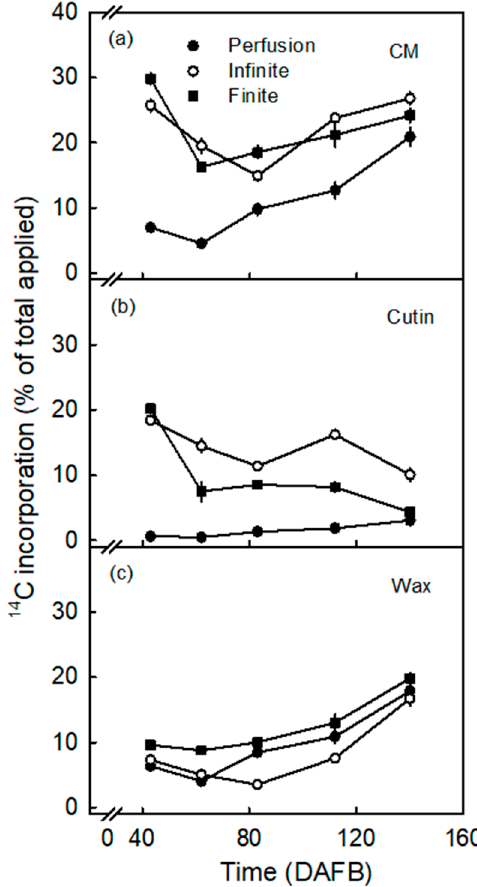
Figure 5. Effect of fruit development stage on 14 C incorporation (% of total applied) in cuticular membrane (CM) ( a ), cutin ( b ) and wax ( c ). 14 C labelled oleic acid was applied to the excised exocarp segments (ES) of ‘Idared’ apples, sampled at various stages of development between 43 days after full bloom (DAFB) and maturity (140 DAFB), using three different application methods. The values are means ± SEs of 15 replications. Table 1. Incorporation of 13 C or 14 C (% of total applied) in the cuticular membrane (CM), cutin and wax of young (62 or 65 days after full bloom; DAFB) ‘Idared’ apple fruit. In vivo: Three alternative methods were used to apply 13 C labelled oleic acid to the surface of growing fruit in the field. Incorporation was quantified by mass spectrometry. In vitro : 14 C labelled oleic acid was fed to excised exocarp segments (ES) and incorporation quantified by radioactivity counting. For details see Materials and Methods. The values are means ± SEs of 8–15 replications.